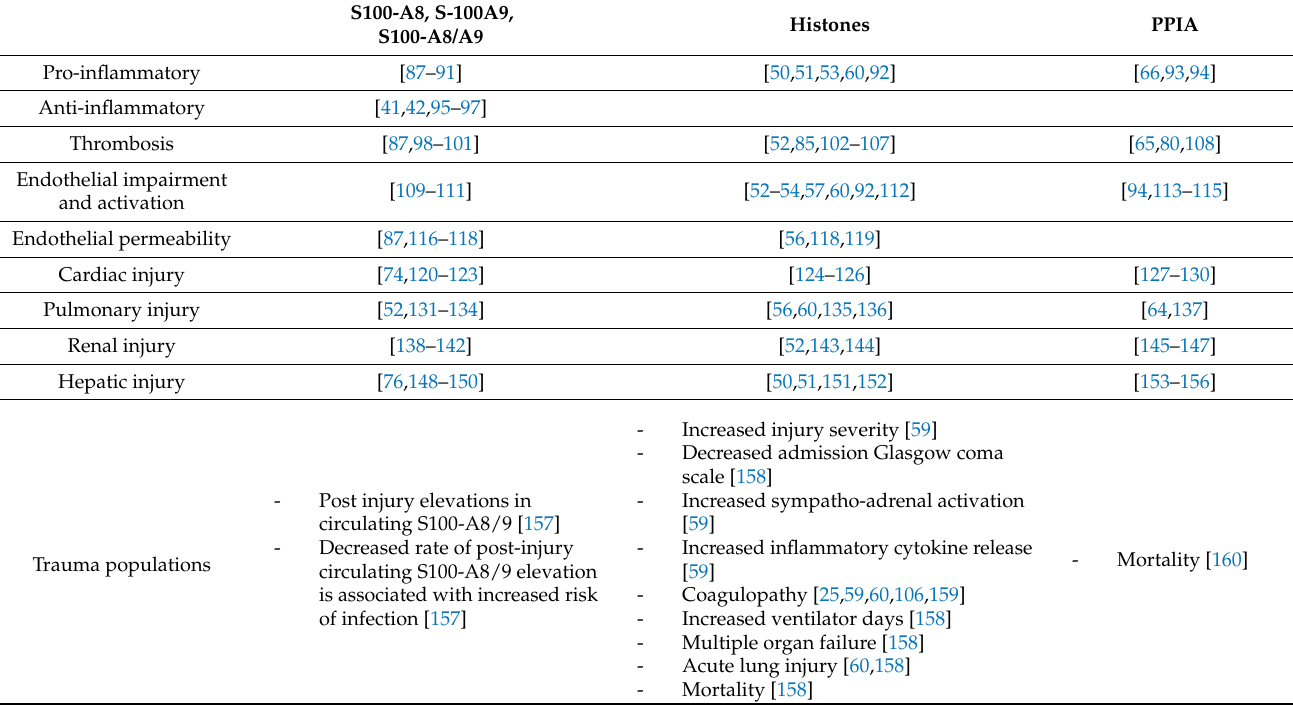
Table 6. Damage-associated molecular patterns with increased abundance in the EoT group and associations with pathophysiology relevant to the systemic response to